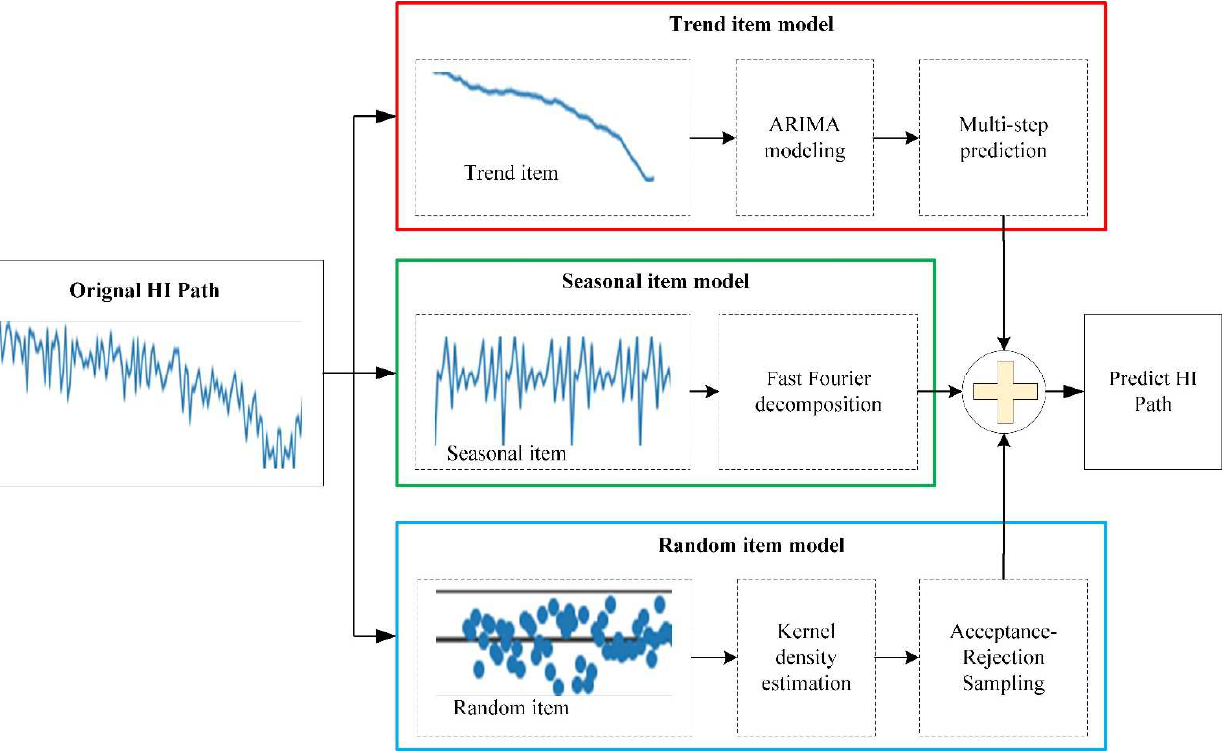
Figure 5. Degradation path prediction based on STL modeling.